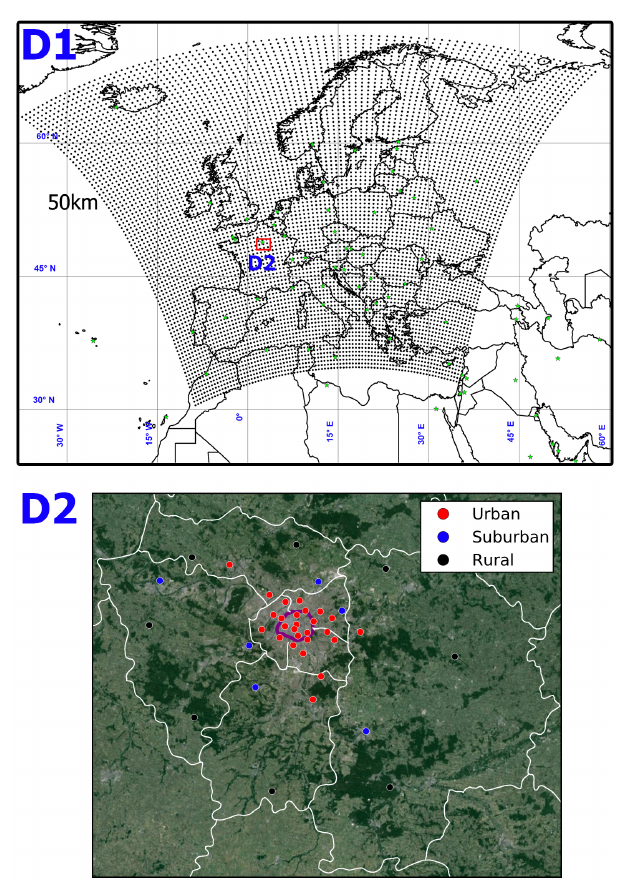
Figure 1. Overview of the coarse (D1 having 50km resolution) and local scale (D2, illustrated by the red rectangle having 4km reso- lution) simulation domains. In D2, the city of Paris in located in the area enclosed by the purple line. Circles correspond to sites of the local air-quality monitoring network (AIRPARIF), with red for urban, blue for suburban and black for